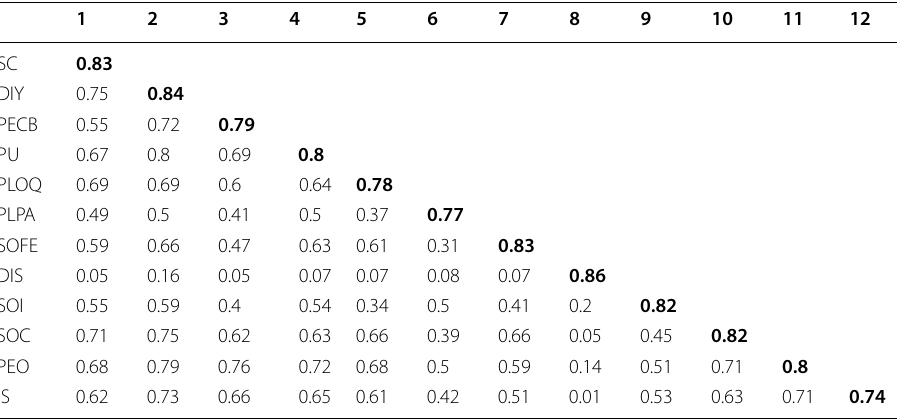
The diagonal row highligted in bold represents the square roots of the